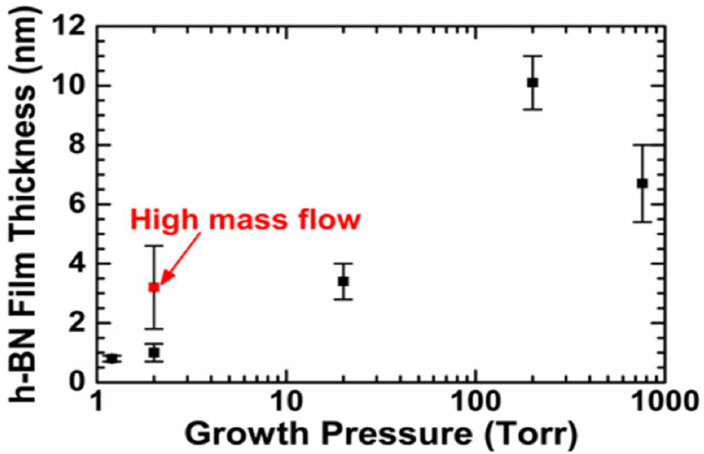
Figure 15. h-BN film thickness versus growth pressure, showing thin h-BN films at LPCVD [74]. Cu has three main orientations: Cu (111), Cu (100), and Cu (111). Song et al.